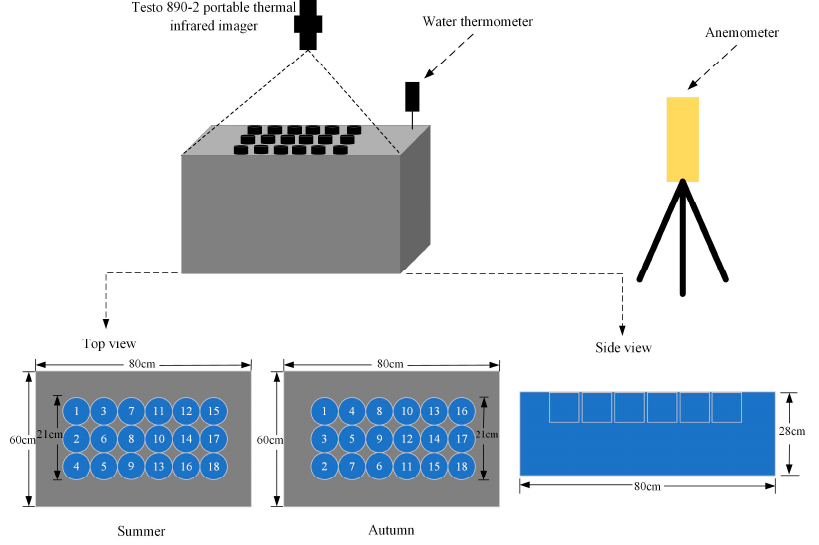
Figure 1. Schematic diagram of oil film thickness detection in small scenes.